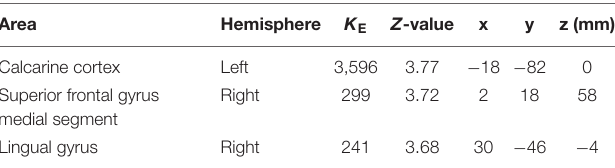
TABLE 5 | Significantly activated regions and their z -values and coordinates in the difference between autonomous sensory meridian response (ASMR) stimulation and classical